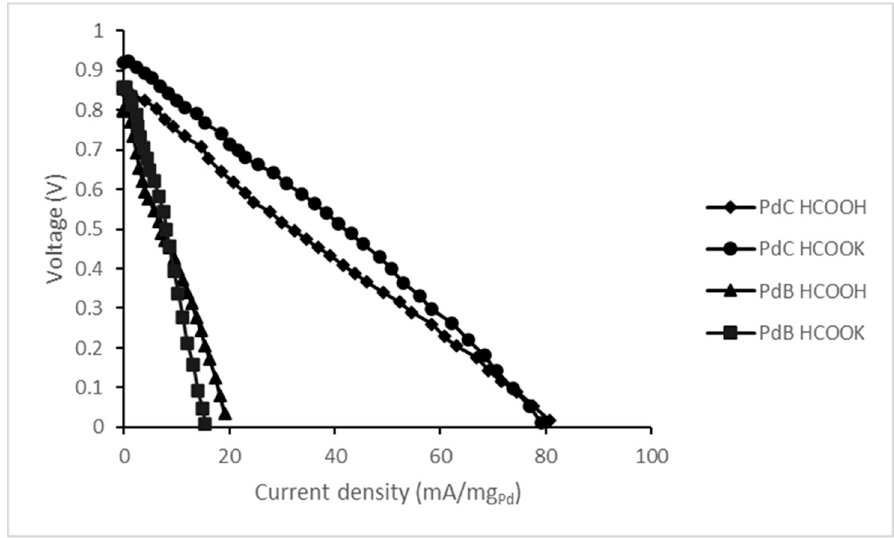
Figure 5. Polarization curves of the developed formate/formic acid fuel cells.